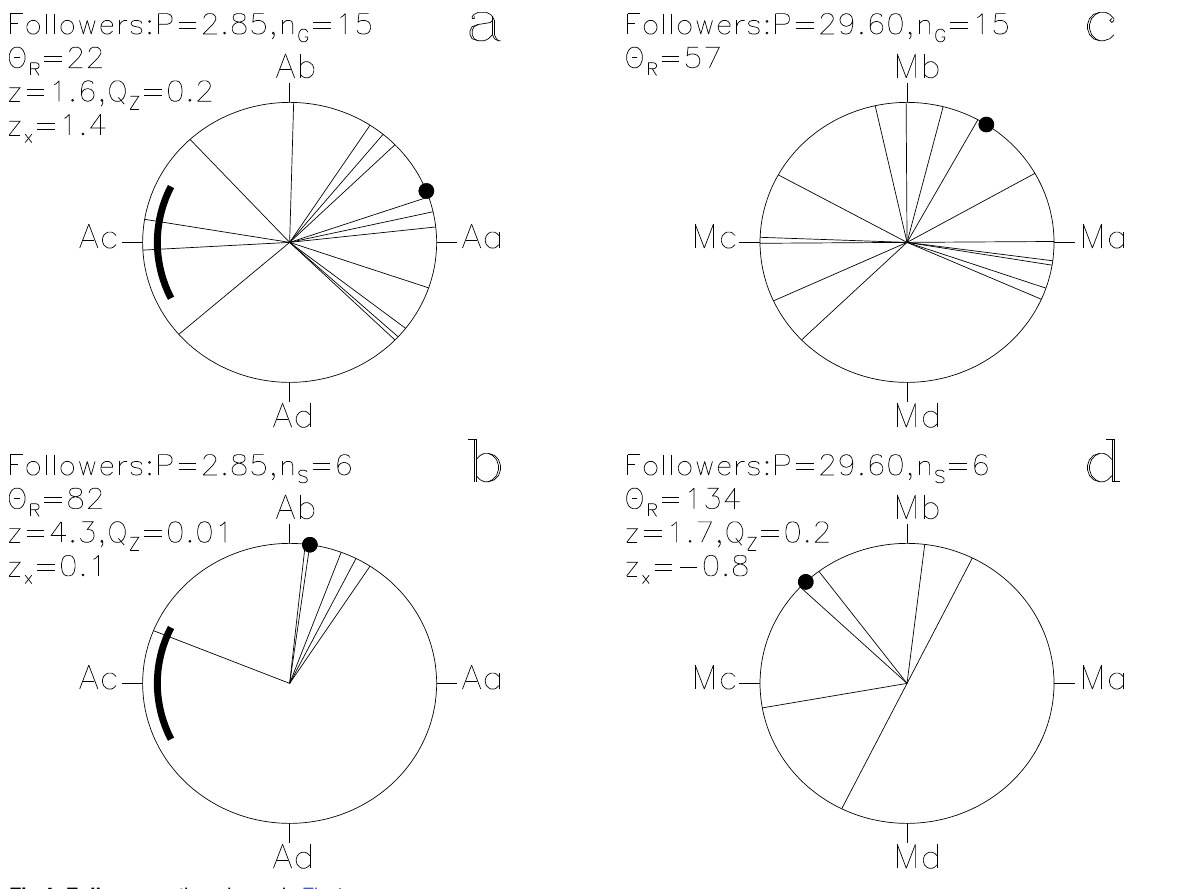
Fig 4. Followers. otherwise as in Fig